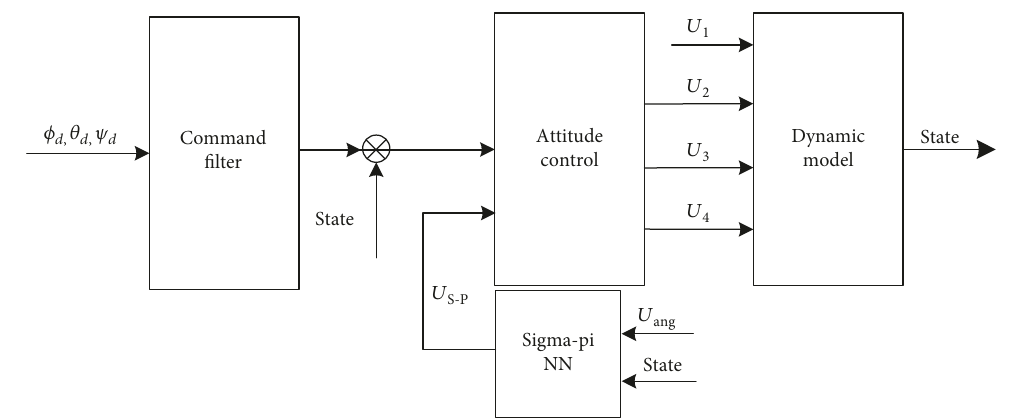
Figure 4: The quadrotor attitude control